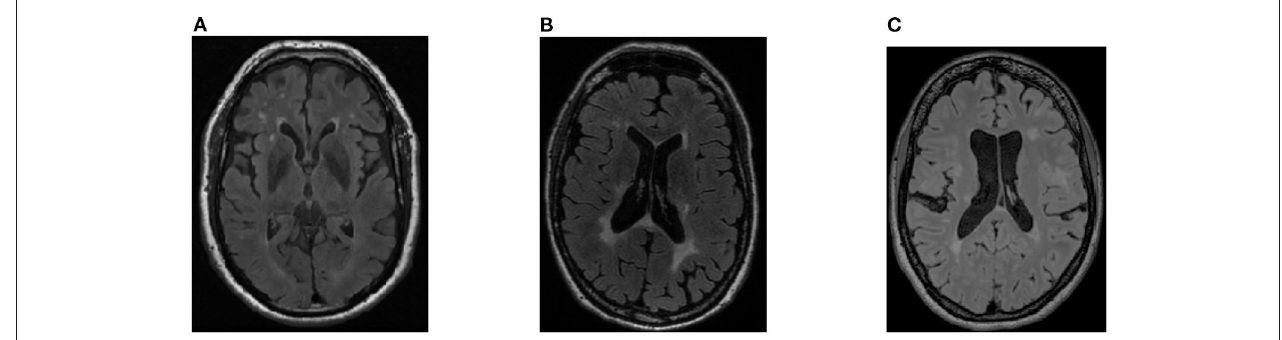
FIGURE 2 | Example of fluid-attenuated inversion recovery (FLAIR) images in a multi-site dataset: (A) healthy control participant imaged on a specific scanner vendor; (B) a patient with a pathology (white matter hyperintensities, WMH, Wardlaw et al., 2013) imaged on the same scanner vendor; (C) a second patient with WMH pathology imaged on a different scanner vendor. Images acquired using different scanner vendors may present different image contrasts, shape, and other characteristics. These varying characteristics may impact the DL models development and performance due to unwanted correlations in the dataset (that are not correlated with the pathology